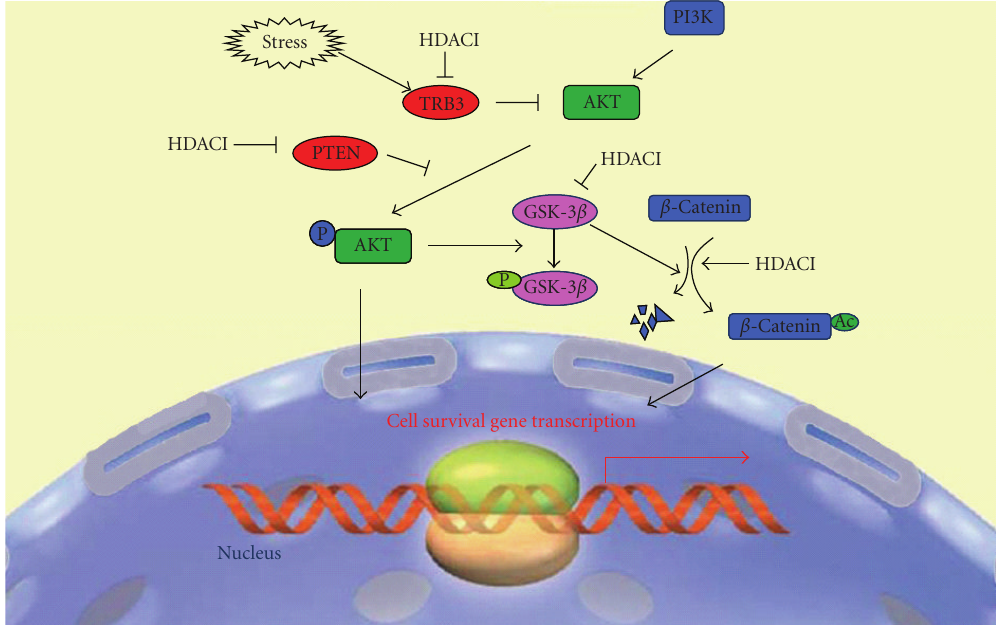
Figure 1: E ff ect of HDACIs on cell survival in hemorrhagic shock. HDACIs induce phosphorylation of AKT by inhibition of TRB3 and PTEN. While AKT stimulates transcription of cell survival genes through several other pathways, phosphorylated AKT also phosphorylates GSK-3 β . Phosphorylated GSK-3 β becomes inactivated form, which cannot degrade β -catenin. HDACIs (e.g., VPA) can also directly inhibit GSK-3 β . Moreover, HDACIs induce acetylation and nuclear translocation of β -catenin, leading to downstream survival gene transcription. P, phosphorylation; Ac,